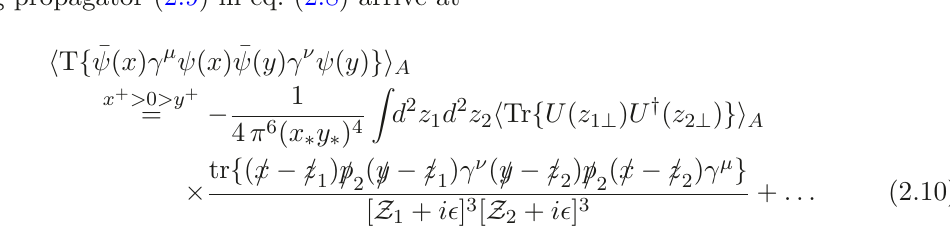
Figure 1 . Diagram for the LO impact factor in the eikonal approximation. As usual, we will indicate in blue the quantum field and in red the classical background ones. with x µ γ µ = /x . In figure 1 the blue lines represent the quark and anti-quark fields, while the red band represents the background shock-wave